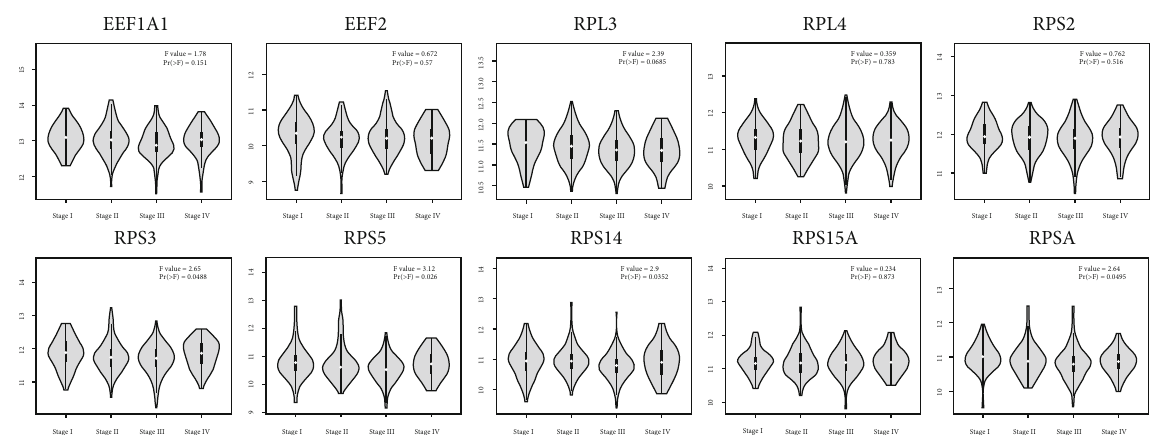
Figure 6: The stage-speci fi c mRNA expression of hub genes by violin plot using the GEPIA platform. READ: rectal adenocarcinoma; COAD: colon adenocarcinoma; tumor: red; normal: (CC), and molecular function (MF), were displayed if more than 10 terms were de fi ned as signi fi cant ( p value < 0.05).